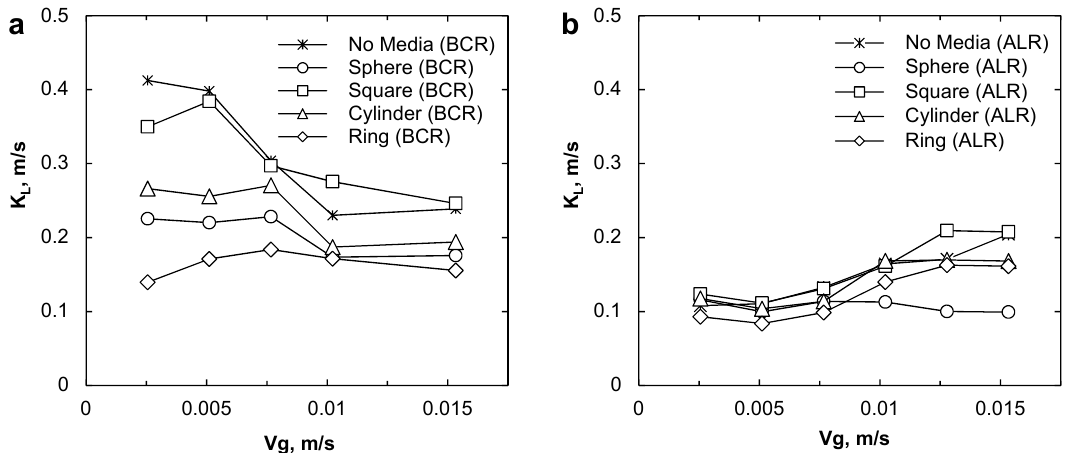
Figure 9. Estimated liquid-side mass transfer coe ffi cient (K L ) coe ffi cient with di ff erent solid media types and 10% loading in: ( a ) BCR and ( b ) ALR.